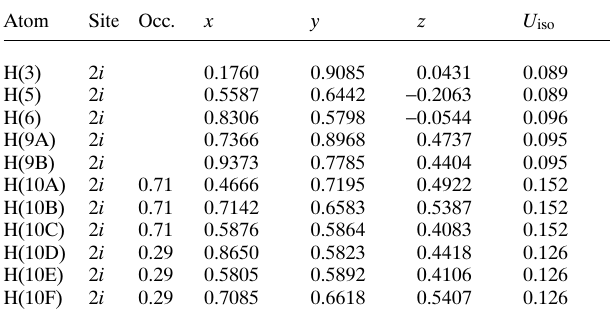
Table 2. Atomic coordinates and displacement parameters (in Å 2 ) .